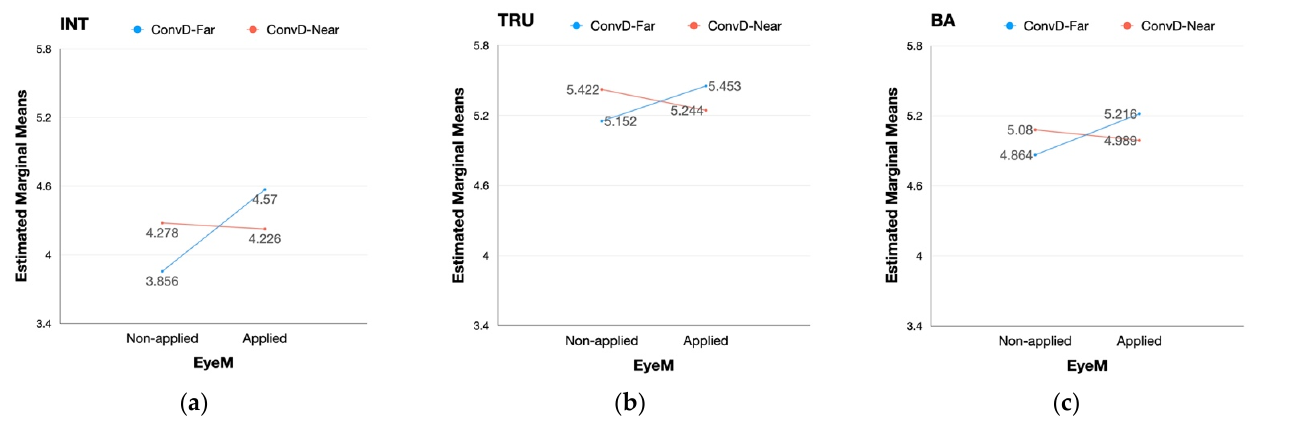
Figure 4. Full sample: interaction effect between eye movement (EyeM) and conversational distance (ConvD); ( a ) interaction effect on intimacy; ( b ) interaction effect on trust; ( c ) interaction effect on brand attitude.